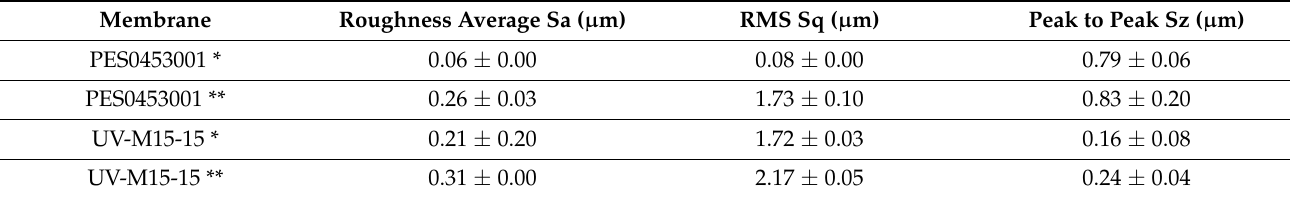
Table 6. Surface roughness of UV-M 15-15 and commercial PES membranes, before and after the anti-fouling experiment.